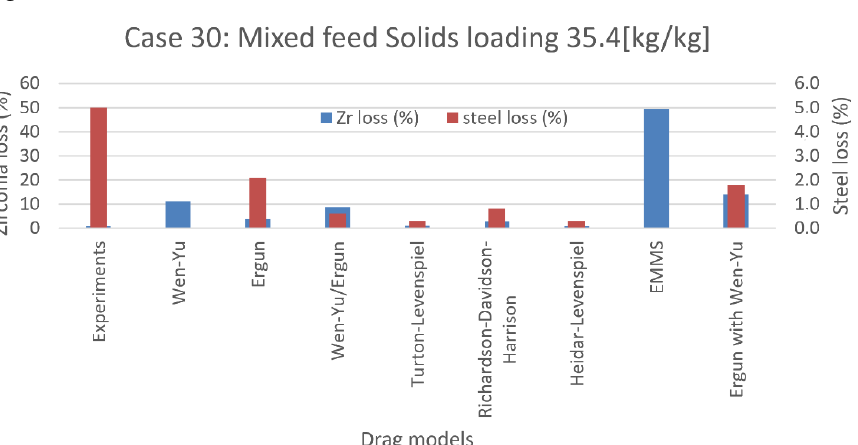
Figure 11. Zirconia and steel loss for Case 30.